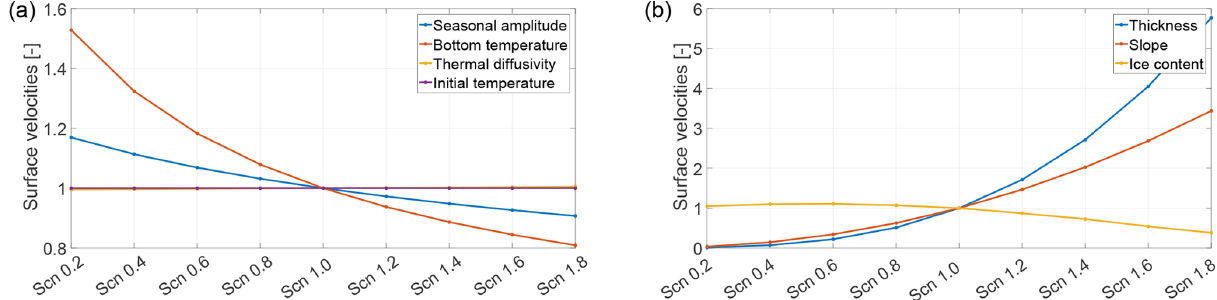
Figure 5. Plots of the time-averaged values of surface velocities for the sensitivity experiments with the different parameter scenarios. The mean velocities are normalised with the mean values of the reference scenario Scn1.0. Panel (a) shows the results for varying surface temperature-forcing amplitudes (blue line), bottom temperature values (red line), thermal diffusivity parameters (yellow line) and initial condition temperature values (purple line). The yellow line is hidden behind the purple line. Panel (b) shows the results for varying thicknesses (blue line), slope angles (red line) and volumetric ice content values (yellow line).